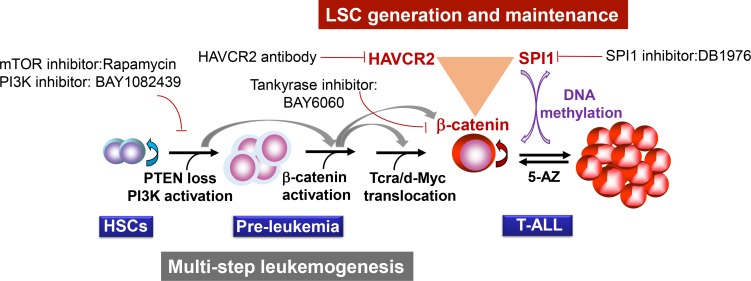
Two-layer control mechanisms for leukemogenesis and LSC maintenance.